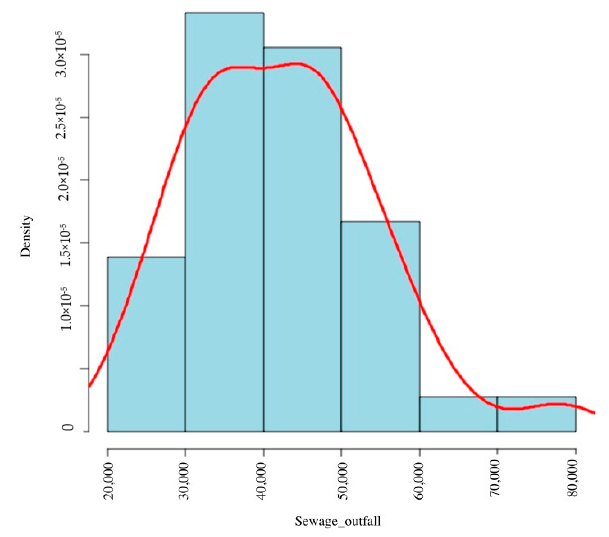
Figure 4. The course of the estimated kernel density function for the mean daily sewage outflow in a particular month from the urban agglomeration of Radom.